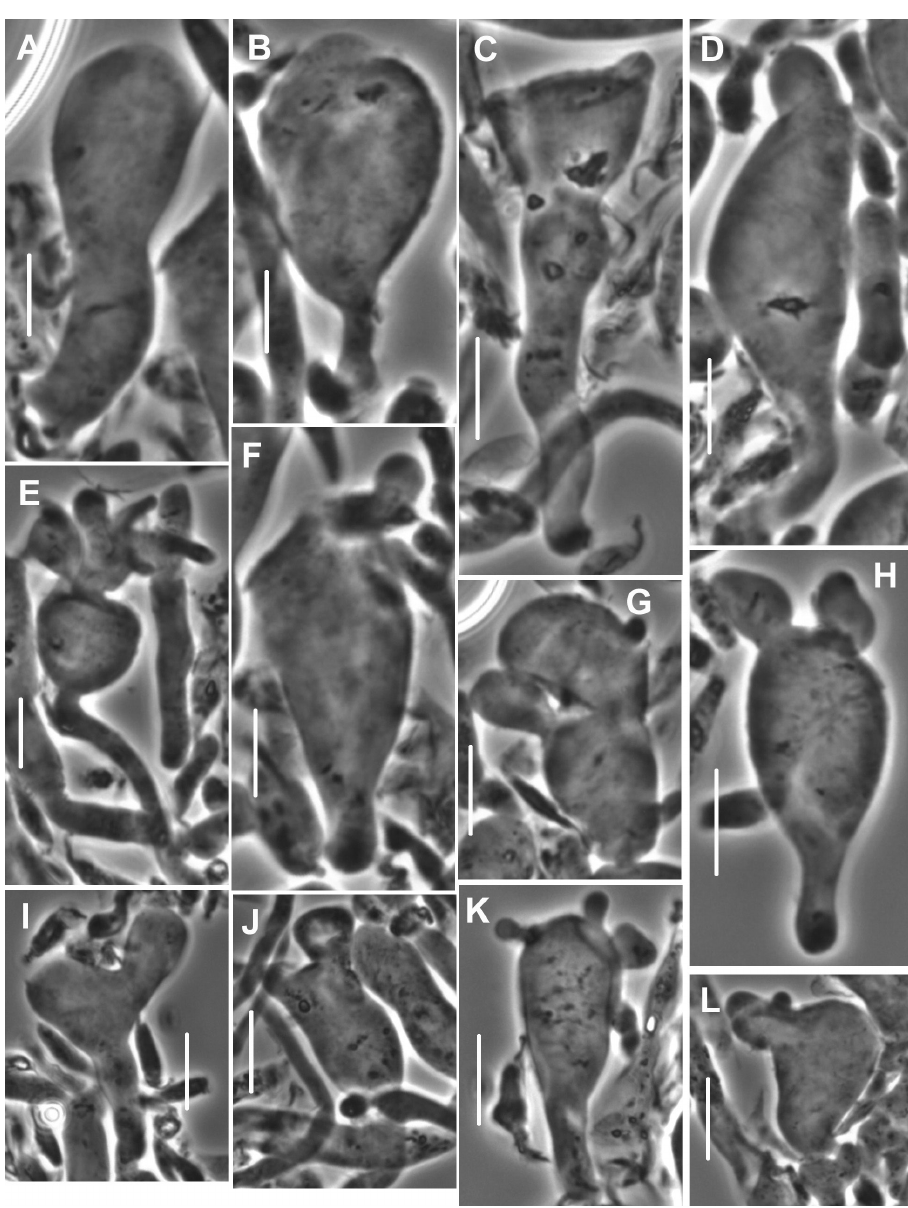
Figure 46. Mycetinis olidus . Clavate cells from lamella edge. Standard bars = 10 µm. DED 4529 (TENN